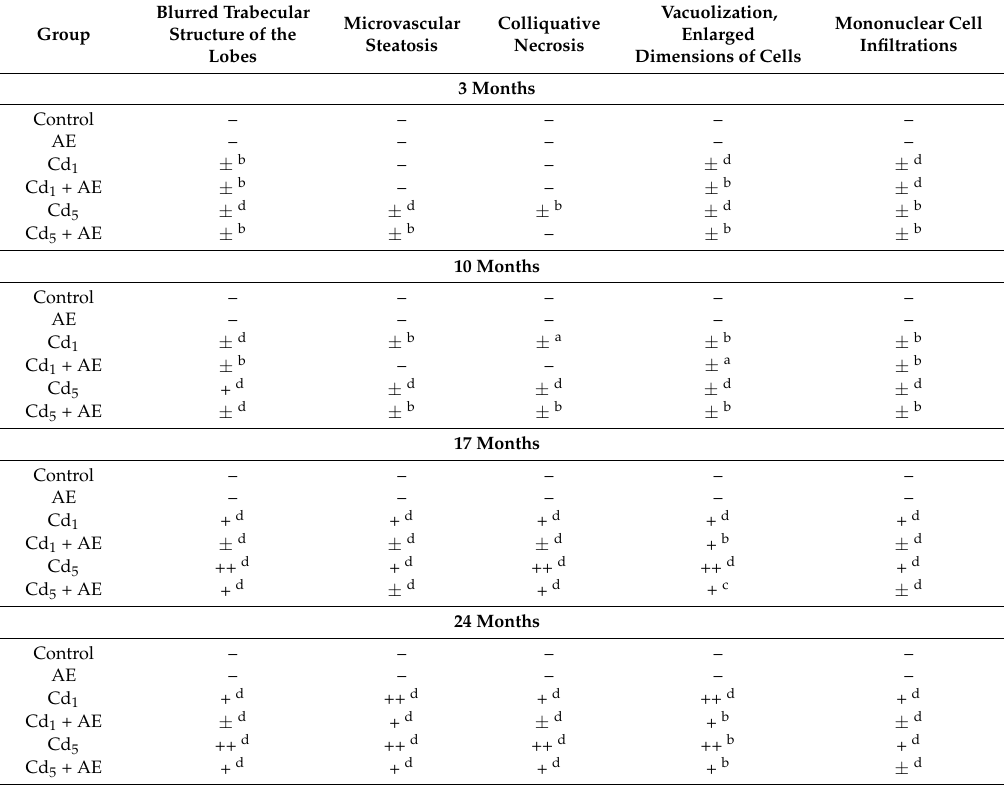
Table 1. The effect of the extract from the berries of Aronia melanocarpa L. (AE) on the liver morphology of rats exposed to cadmium (Cd) 1,2